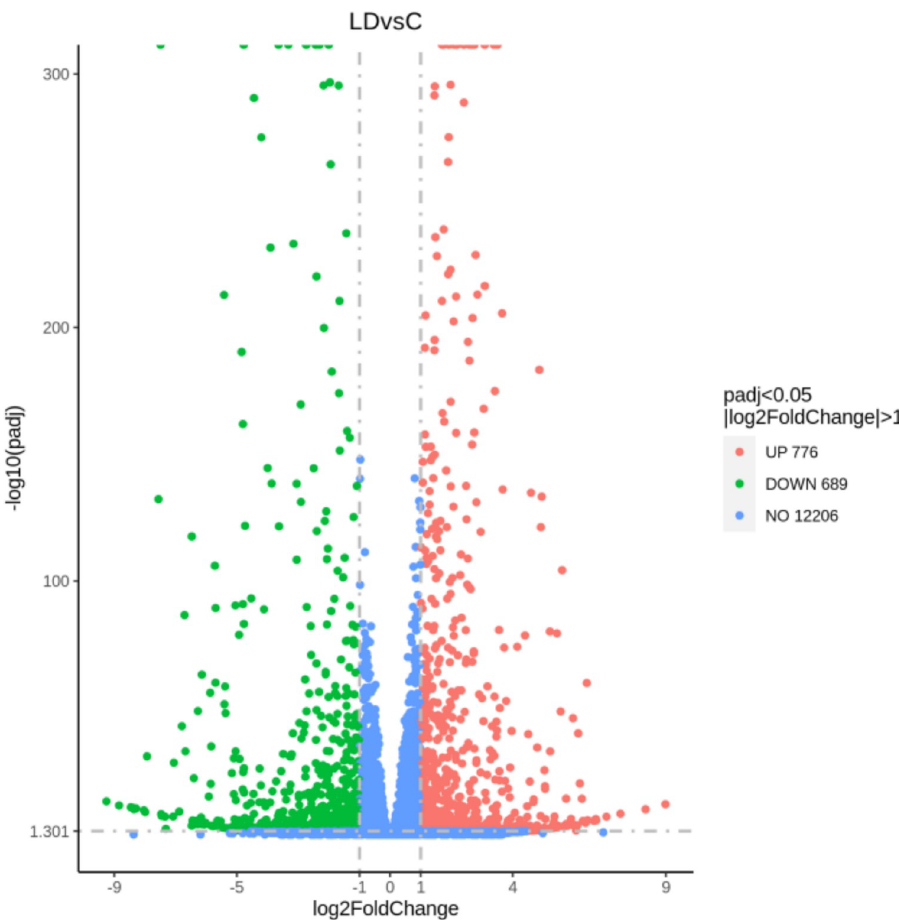
Fig 4. RNA-Seq analysis of C and LD-Aag2 cells reveals differentially expressed genes. Volcano plot of upregulated and downregulated genes comparing uninfected C and LD-Aag2 cells.